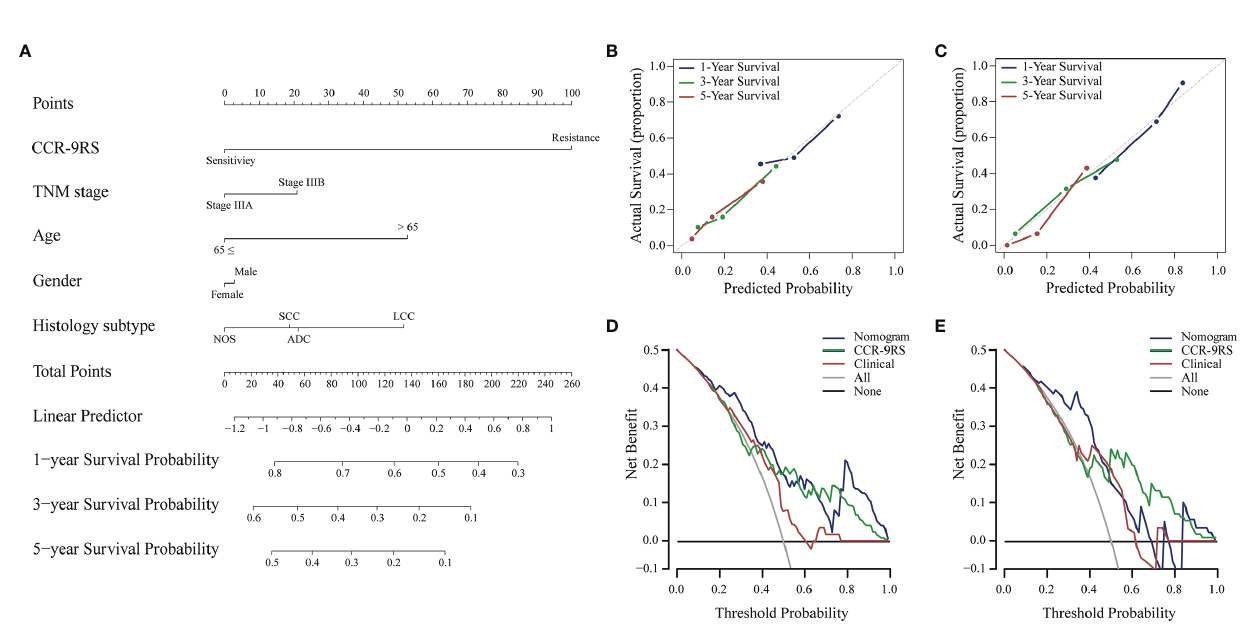
FIGURE 4 | Radiomic nomogram and its performance for patients with NSCLC receiving CCR treatment. (A) Survival radiomic nomogram that incorporated with CCR-9RS and the clinical factors trained in the discovery cohort ( n =153). The points of CCR-9RS and the clinical factors were obtained based on the top ‘ points ’ bar (scale: 0 – 100). The total point was calculated by summing the two points, and a line was drawn downward to the survival axes to determine the likelihood of 1-, 3-, or 5-year survival rate. (B, C) Calibration curves for the radiomic nomogram in the discovery and validation datasets; the diagonal gray line represents an ideal evaluation. (D, E) Decision curves for the radiomic nomogram in the discovery and validation